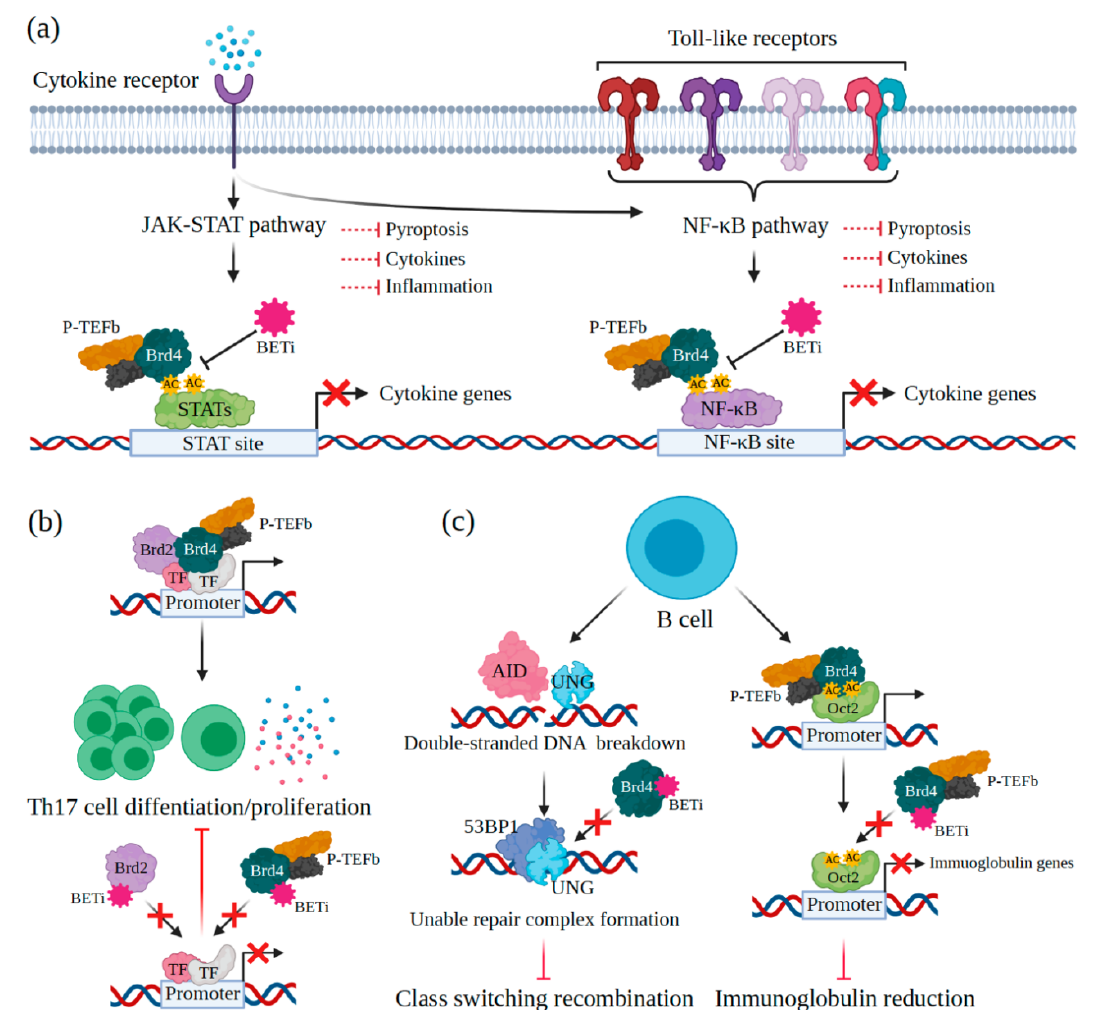
Figure 4. BETis and immune responses. ( a ) BRD4 recognizes an acetyl group on STATs and NF- κ B, which are critical transcription factors in JAK-STAT and NF- κ B signaling pathways, respectively. Once immune cells are exposed to BETis, BRD4 is then blocked, resulting in the decreased expression of cytokine gene. ( b ) BETis directly inhibit the functions of BRD2 and BRD4 mediating Th17 cell differentiation and proliferation in transcription regulation. ( c ) When BETis block BRD4, the repair complex is not formed, leading to the undeveloped CSR in B cells. Besides, after inhibiting BRD4, immunoglobulin genes are significantly suppressed, causing a low antibody level (AID is an activation-induced deaminase). The figure was created with BioRender.com.